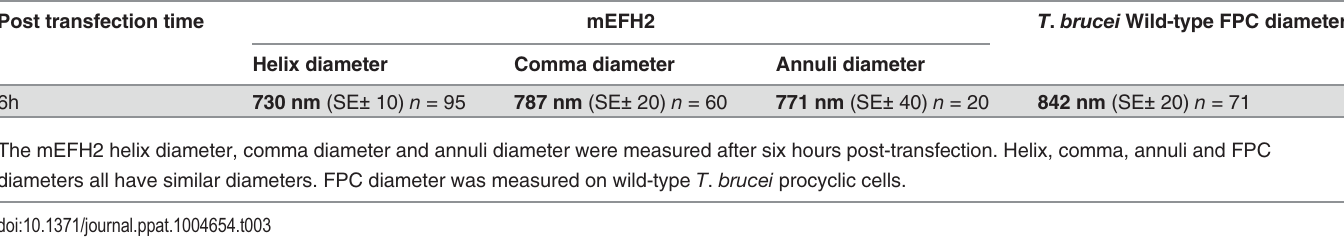
Table 3. Mean mEFH2-induced helix, coma and annuli diameter after expression in U-2 OS cells and mean FPC diameter. Post transfection time